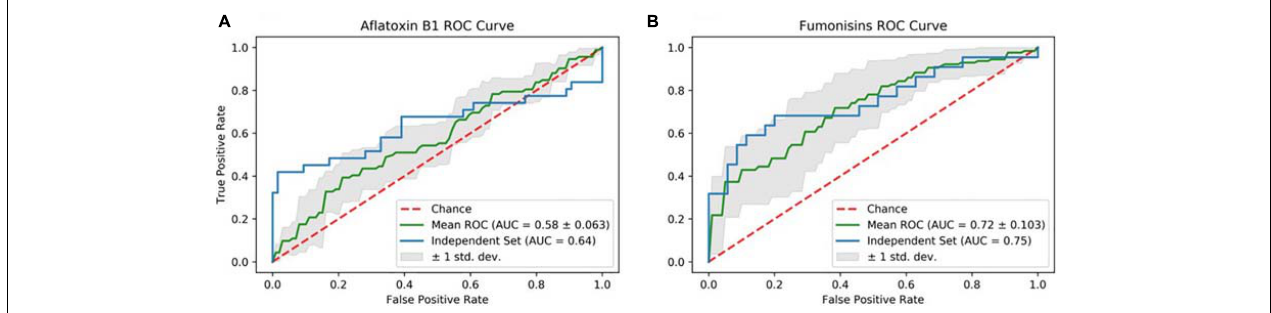
FIGURE 1 | Receiver operating characteristics (ROC) curves for the independent data set for the (A) aflatoxin B1 and (B) FBs models. The solid blue lines represent the ROCs for the two models. The goodness-of-fit of the models is conveyed as the area under the curve (AUC): the higher it is, the better the model performed. The dotted red line represents the random prediction.